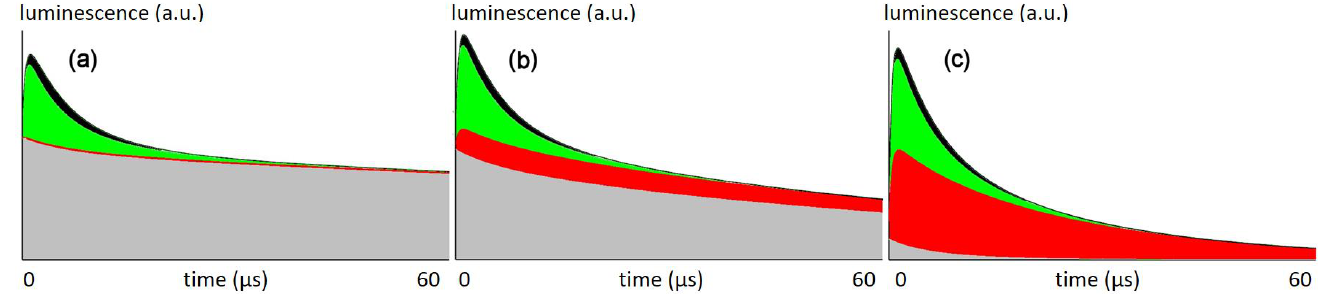
Figure 5. Simulated data for the phosphorescence kinetics in tumors for illumination intensities of ( a ) 66 mW/cm², ( b ) 6.6 mW/cm² and ( c ) 0.66 mW/cm² based on the simulation parameters mentioned in the text and Table 1. Graphs show the calculated luminescence signals for the first 60 µs after excitation pulse, the arbitrary units used here will scale with illumination intensity. Colors indicate signal contributions according to origin and type: 1 O 2 in blood (black), 1 O 2 in vessel wall (green), 1 O 2 in surrounding tissue (red) and total PS phosphorescence (grey).